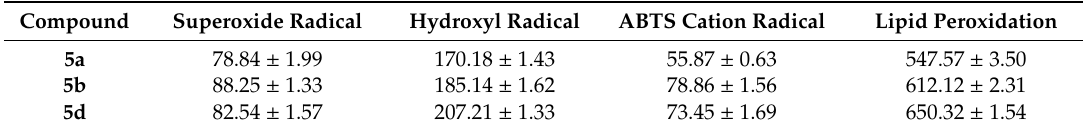
Table 6. IC 50 values of chloro-4-aminochalcones 5a , 5b , and 5d , expressed in µ g / mL.